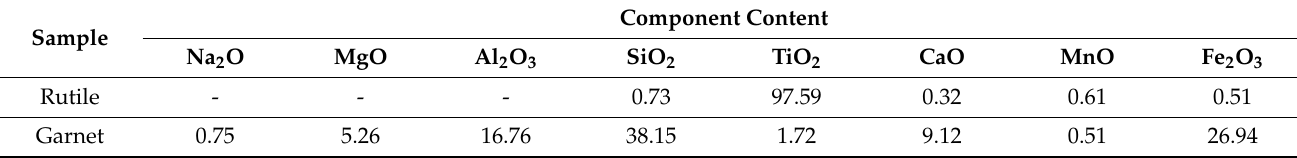
Table 1. Chemical analysis results of rutile and